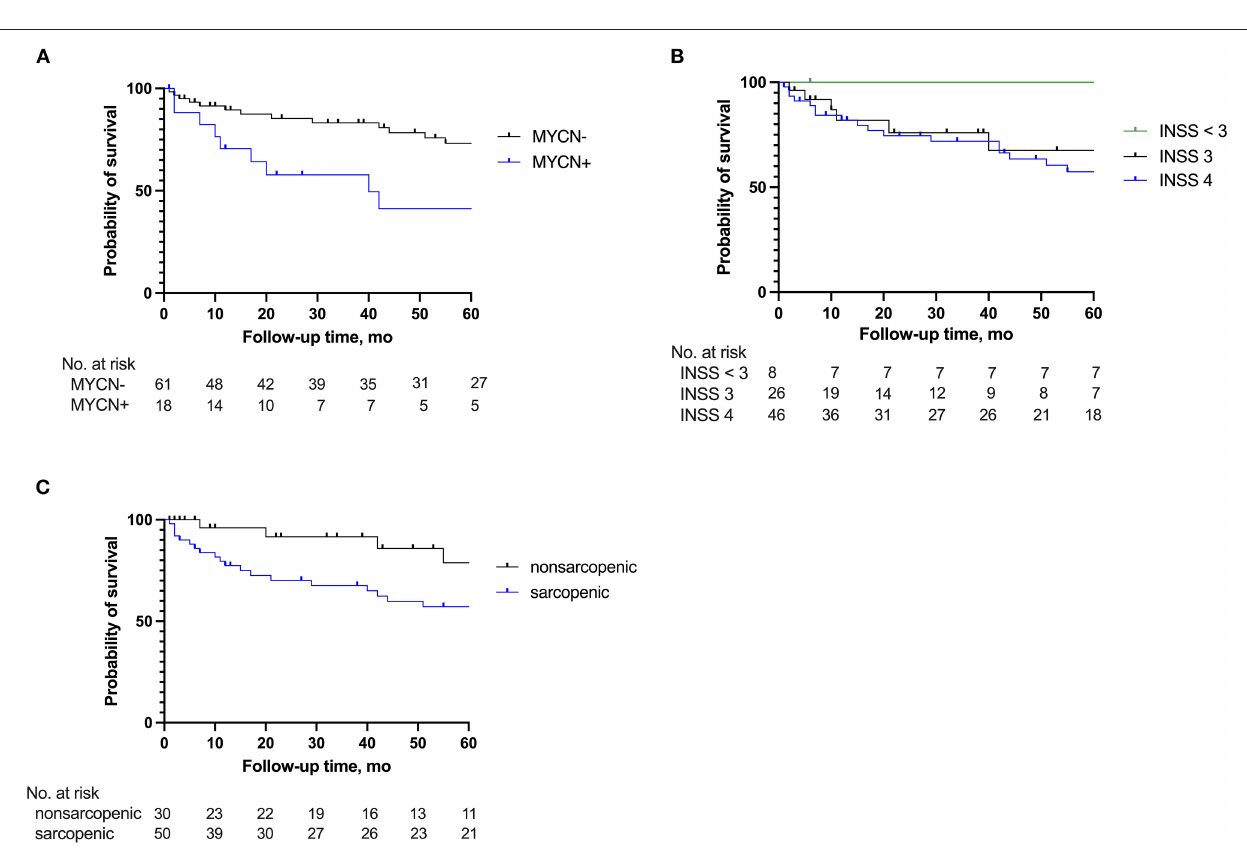
FIGURE 4 | Survival curves 5 years after surgery according to (A) MYCN amplification (MYCN + ), (B) International Neuroblastoma Staging System (INSS) classification, and (C) sarcopenic